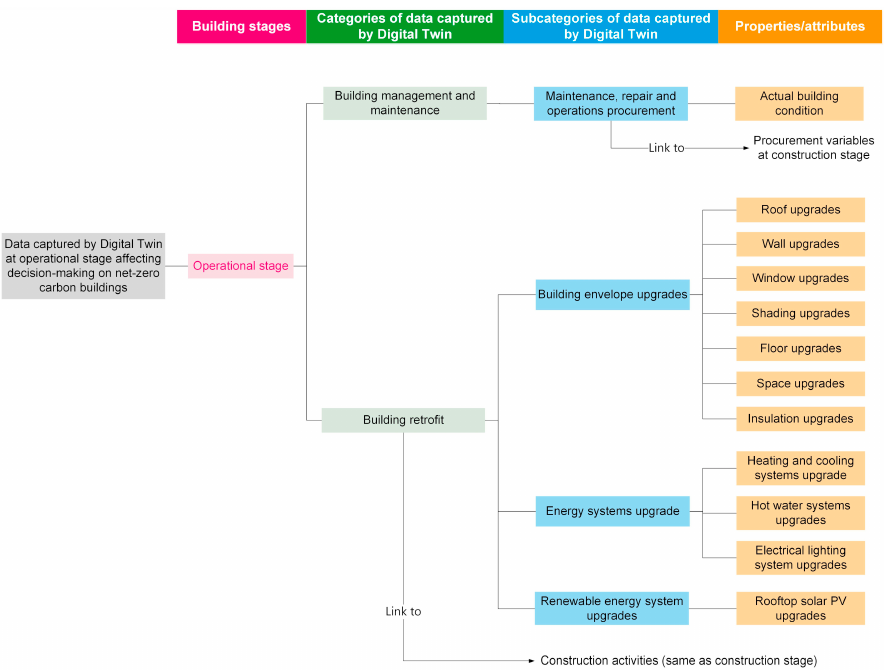
Figure 18. Data captured by DT at operational stage which affect decision-making for net-zero-carbon building.